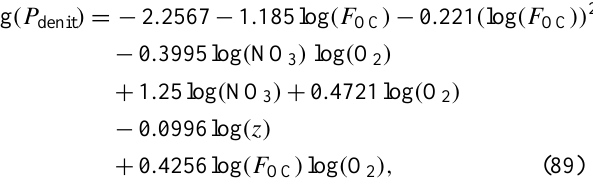
) normalized to its value at PSi